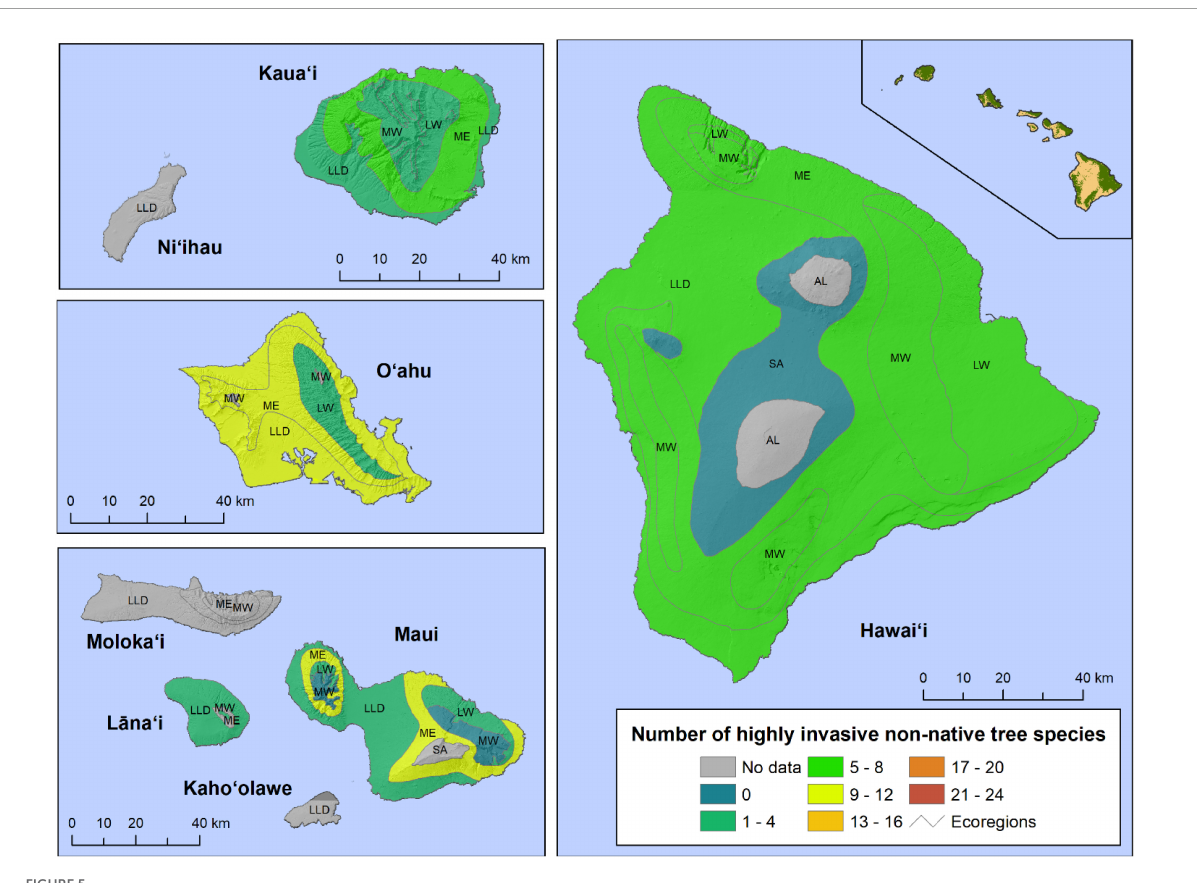
FIGURE5 The number of highly invasive non-native tree species present in each Hawaiian ecoregion, by island, using Forest Inventory and Analysis (FIA) tree occurrence data. (Note the binning of species richness differs from Figure 3 ). AL, alpine; LLD, lowland/leeward dry; LW, lowland wet; ME, mesic; MW, montane wet; SA,